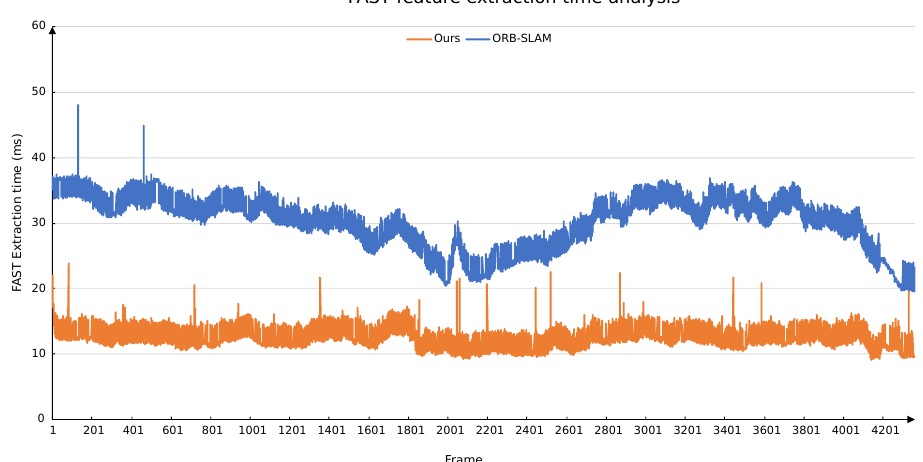
Figure 6. Time analysis of two different feature extraction algorithms on each image in the warehouse